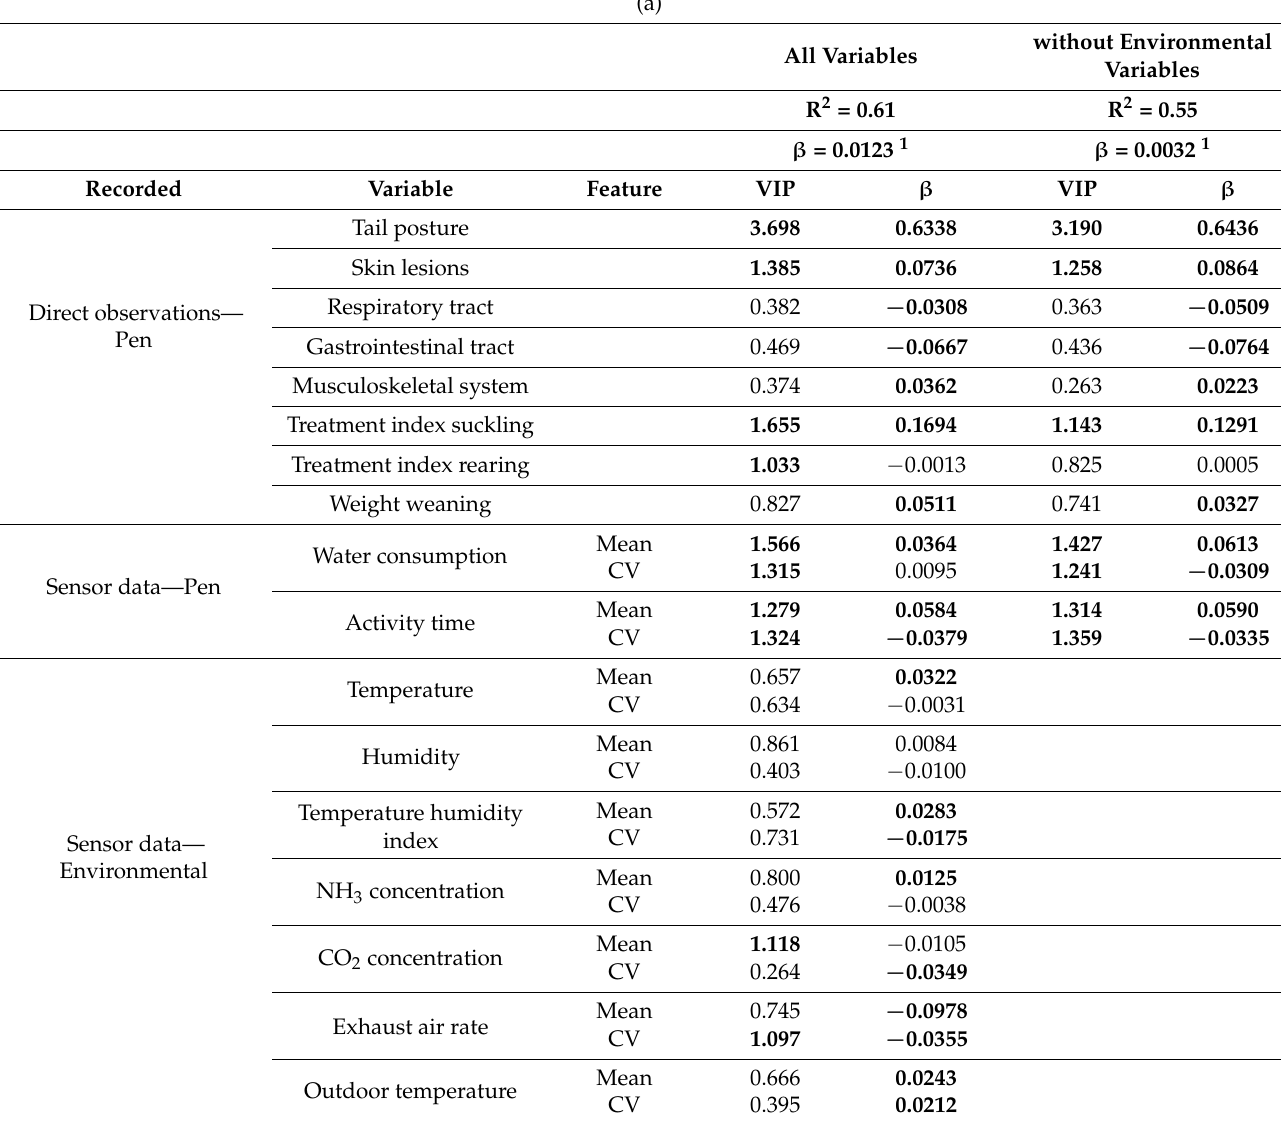
Table 3. Variable importance in projection (VIP) and regression coefficient ( β ) for pen-level and environmental variables collected by direct observation or by using sensors for rearing ( a ) and fattening ( b ) and calculated for all variables and without environmental variables. The sensor data variables were tested as mean and coefficient of variation (CV). (a) without Environmental All Variables Variables R 2 = 0.61 R 2 = 0.55 β = 0.0123 1 β = 0.0032